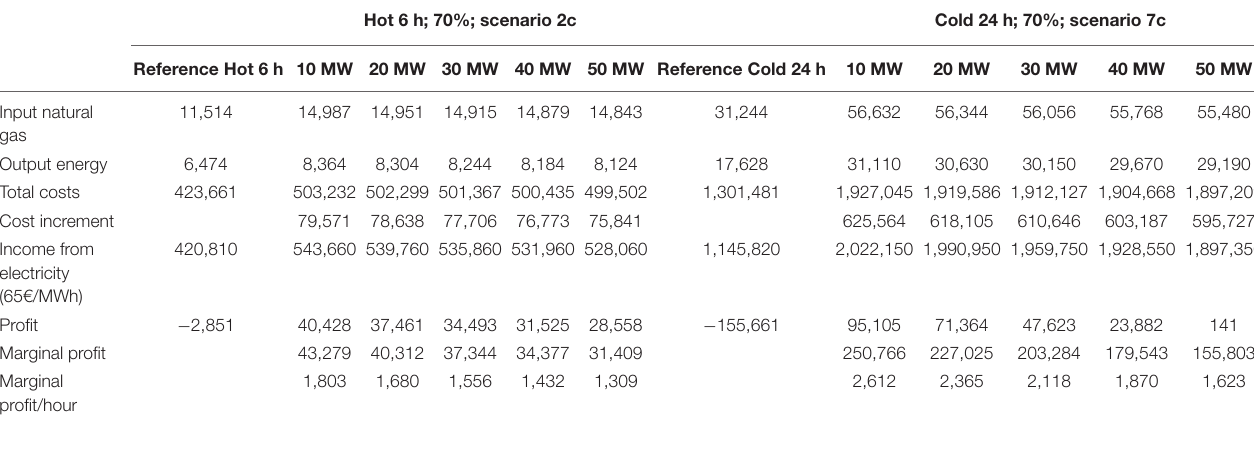
TABLE 9 | Economical comparison by varying the size of the power-to-gas installation for hot (6 h) and cold (48 h): scenarios 2c and